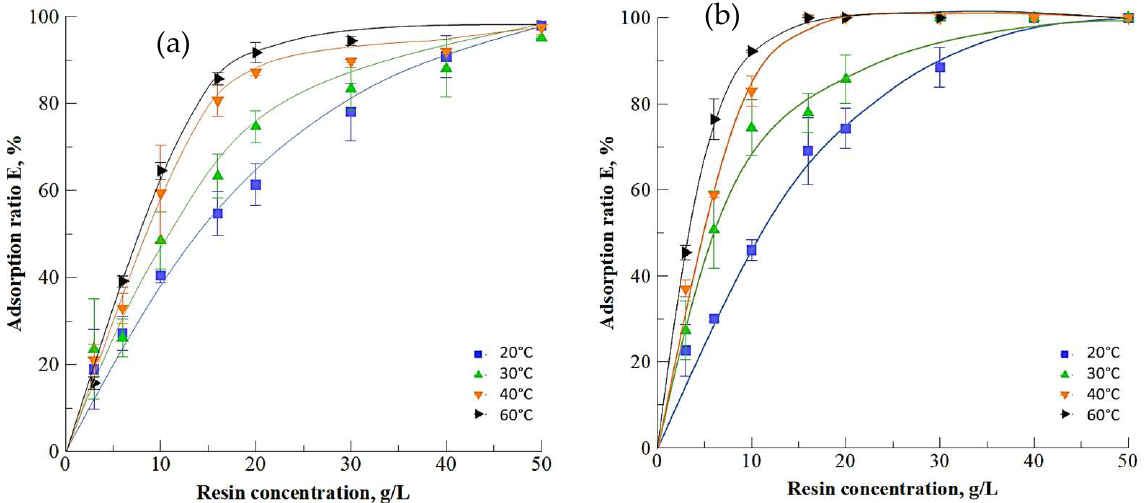
Figure 7. Impact of temperature and PA312LOH resin concentration on the adsorption of ( a ) sinigrin and ( b ) gluconapin at 300 rpm.